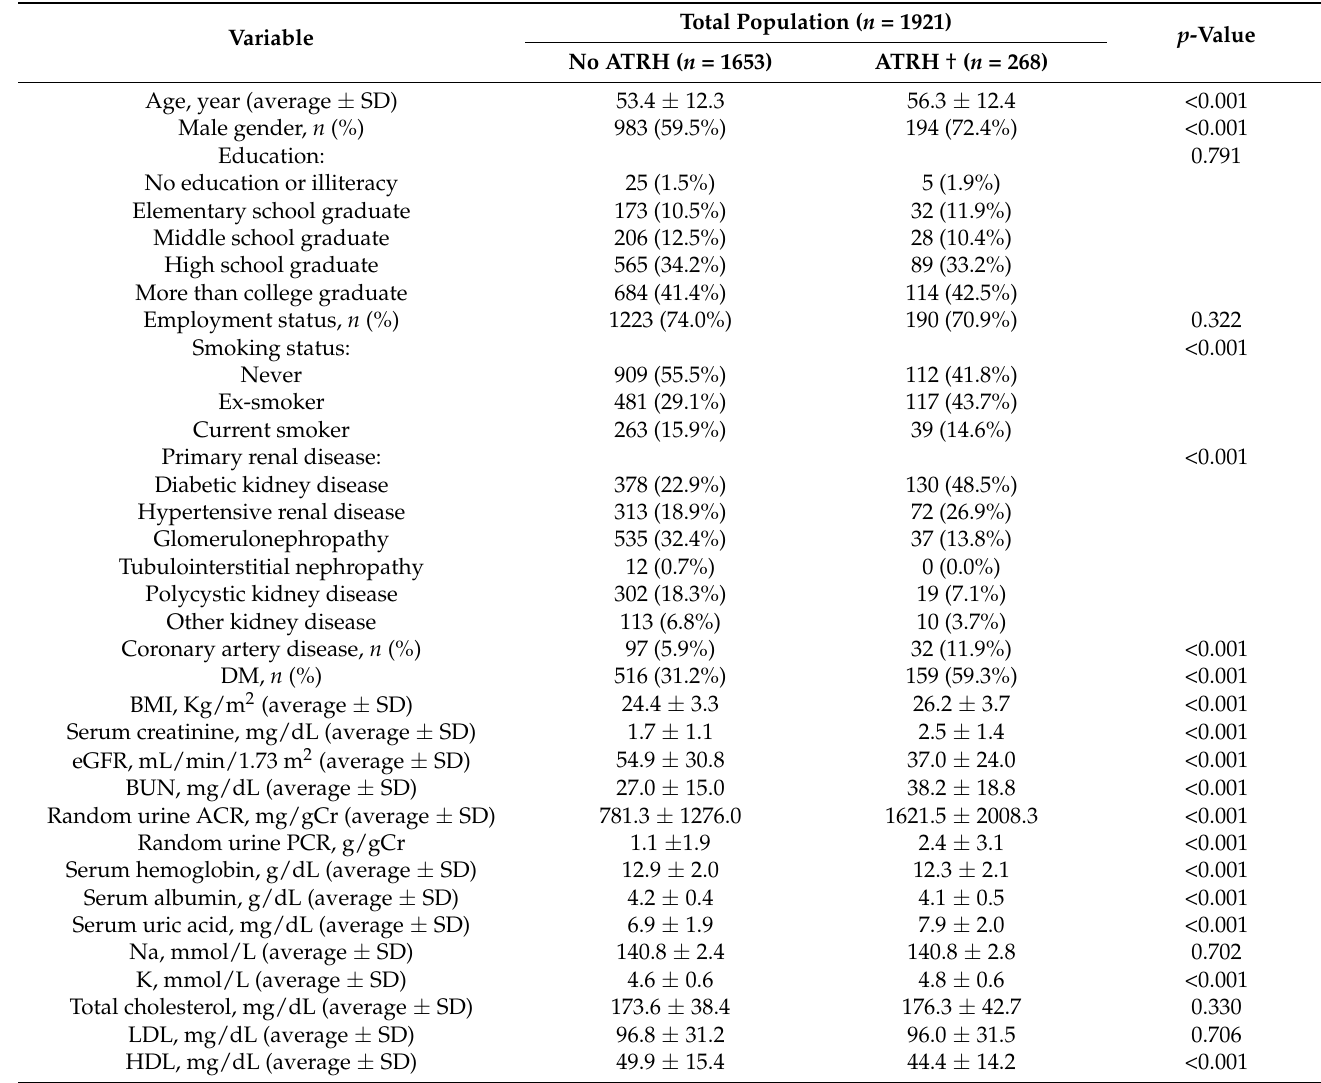
Table 1. Clinical characteristics of the study